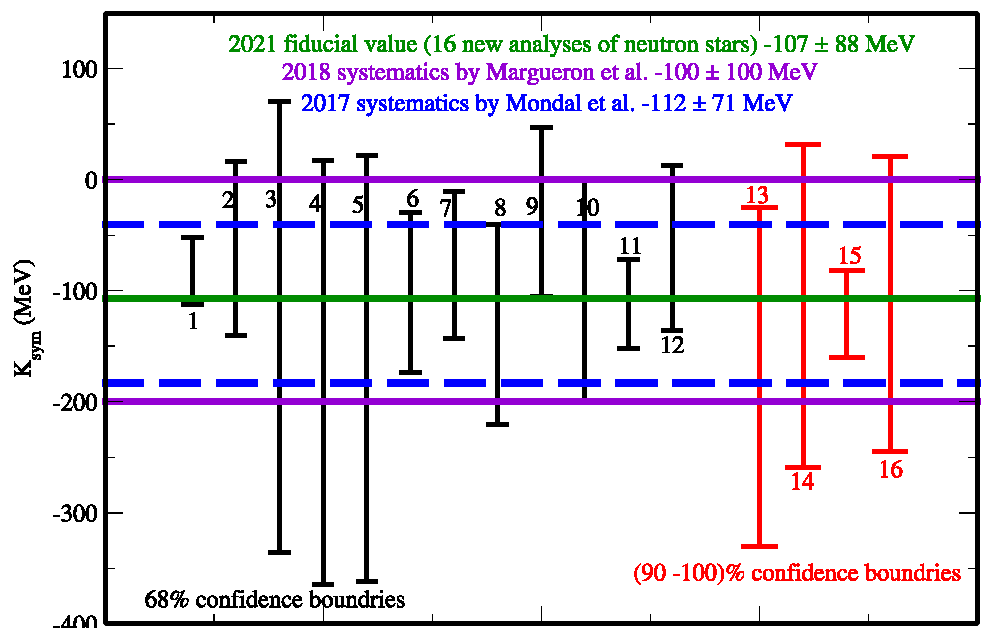
Figure 2. The curvature parameter K sym of nuclear symmetry from the (1) 2017 survey of 500 energy density functional predictions constrained by available terrestrial experiments and astrophysical observations (between the dashed blue lines) [63], (2) 2018 surveys based on a metamodel of nuclear EOS under similar constraints (between the violet lines) [72], and (3) 16 new analyses of neutron star observables since GW170817 (see the detailed list in the text). The green line is the average value of K sym from these 16 new